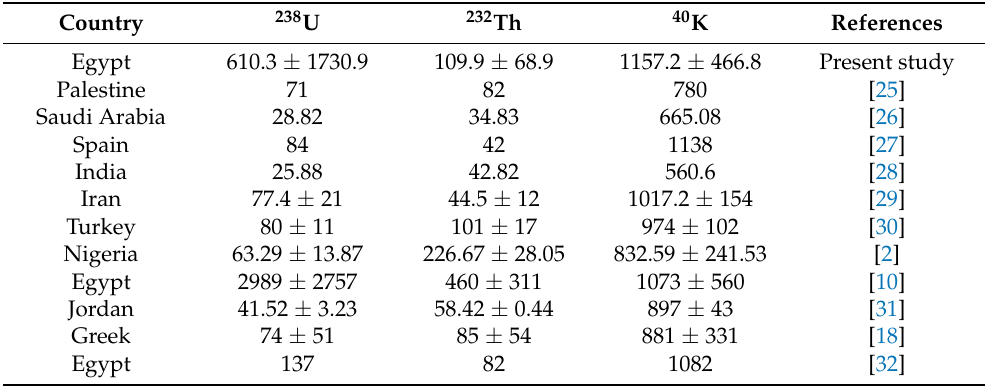
Table 5. A comparison between the activity concentration of radionuclides presented in studied granitic rock and other areas.